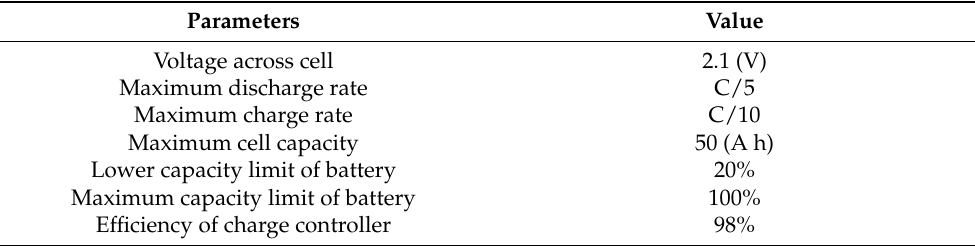
Table 6. The required input parameters of the battery to perform the dynamic analysis.